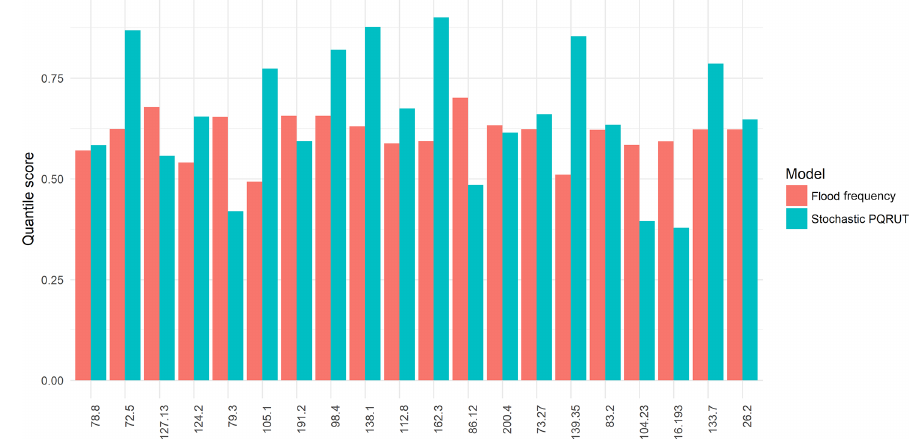
Figure 11. Quantile score (Eq. 5) for estimates based on statistical flood frequency analysis using a GEV distribution (red) and on the stochastic PQRUT model (blue).